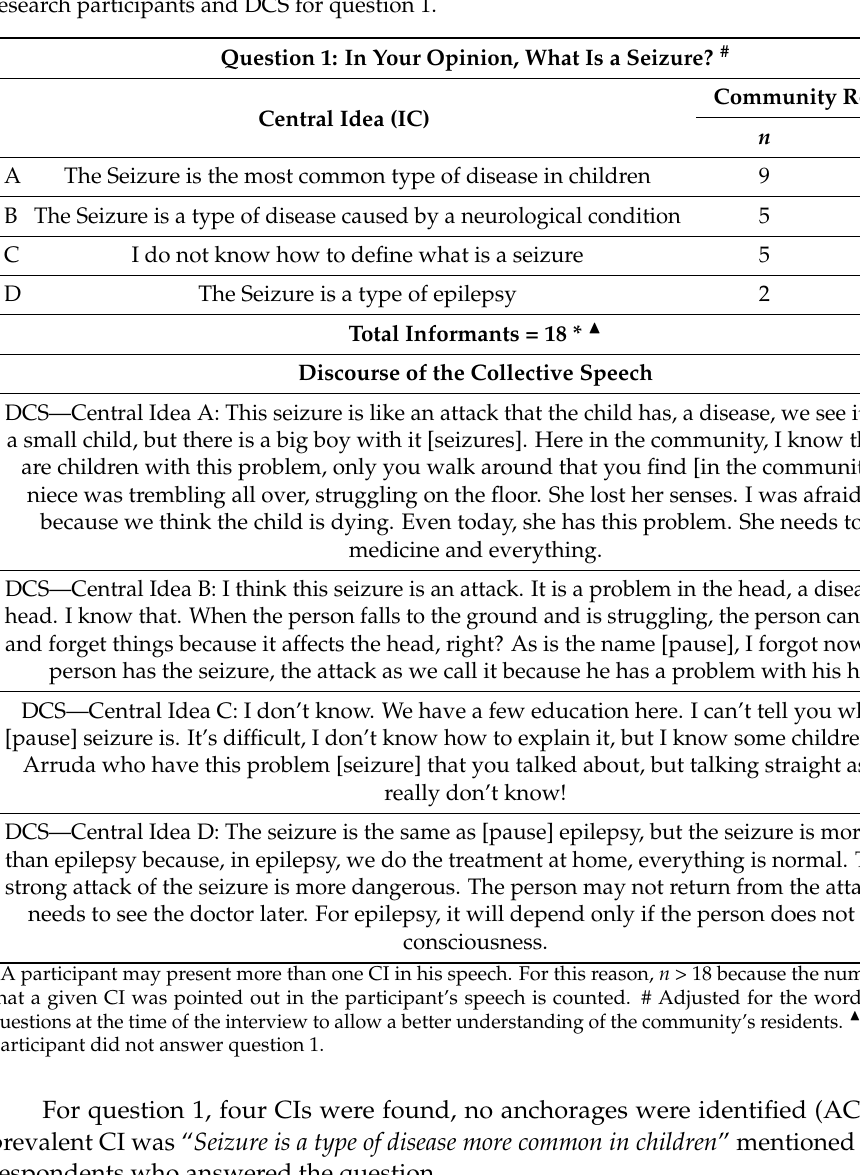
Table 1. Relationship between central idea (CI) of question 1, proportion of responses according to research participants and DCS for question